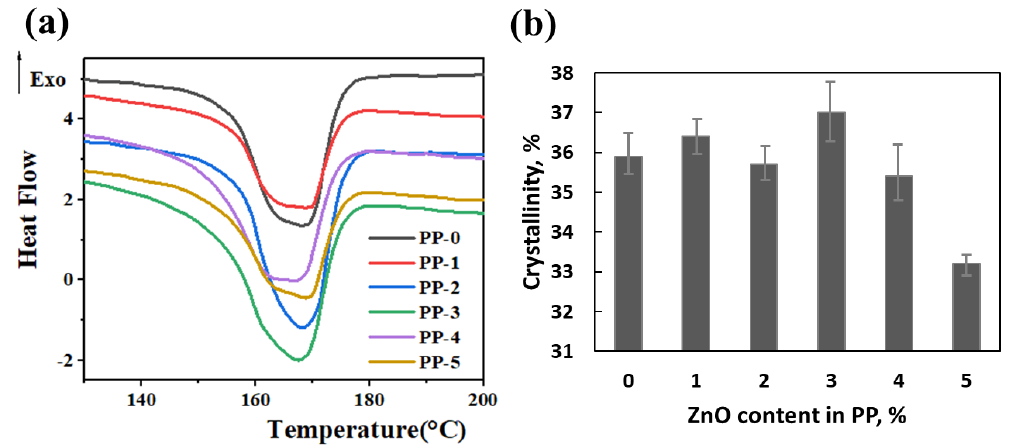
Figure 6. (a) Differential scanning calorimetry (DSC) heating curves and ( b ) crystallinities of PP fibers.